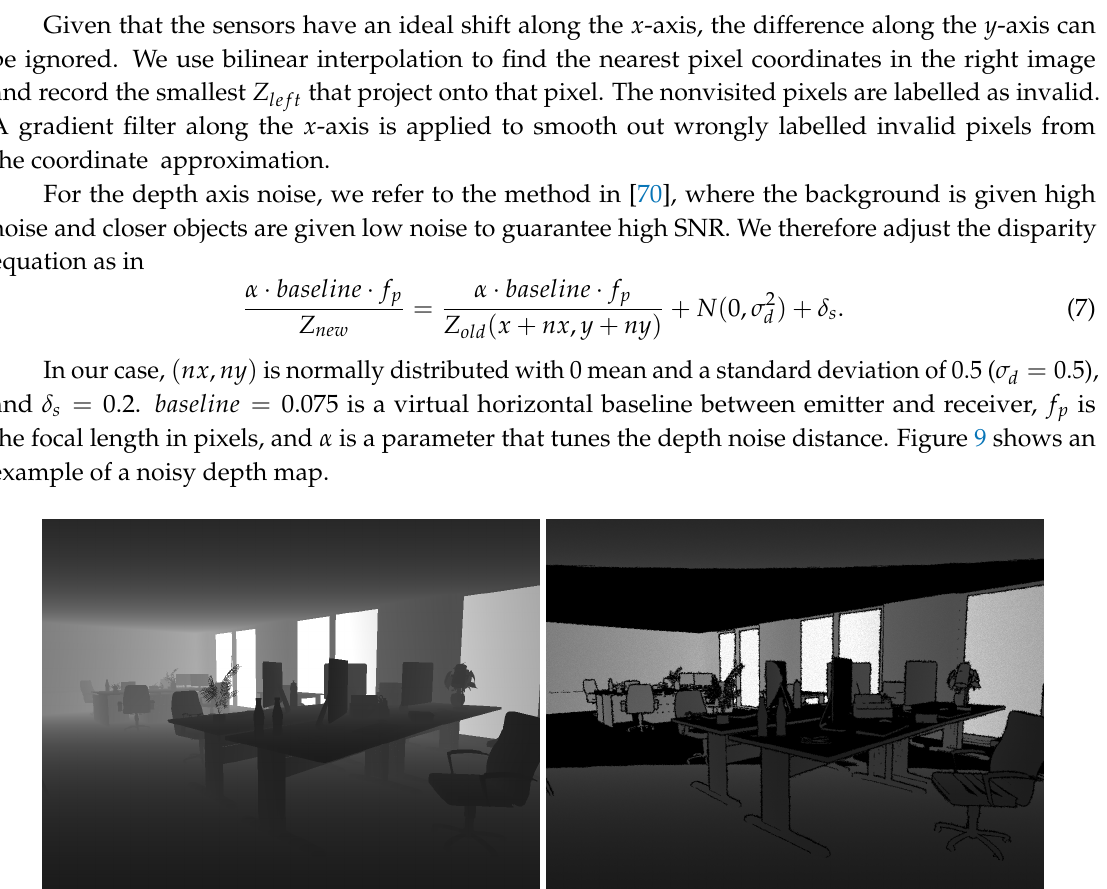
Figure 9. Comparison of a rendered depth image from Blender and a noise-processed realistic depth image. The noisy depth image includes disturbances along the edge, depth collapse, and reserved